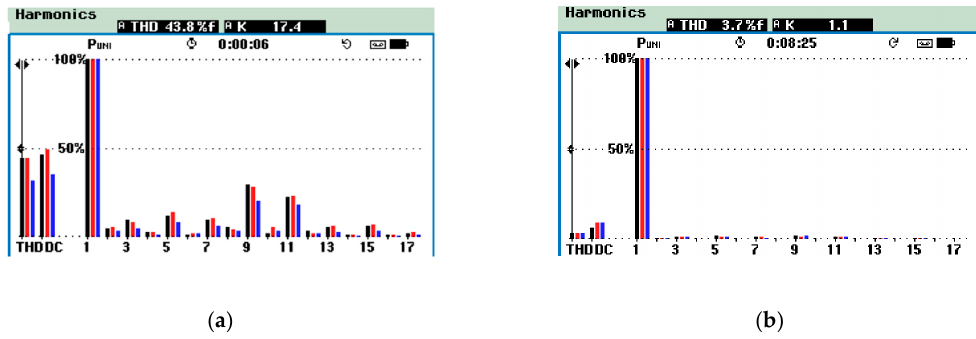
Figure 22. Current spectrum in the PV hybrid micro-grid. ( a ) Load side current spectrum. ( b ) PCC side current compensated spectrum.